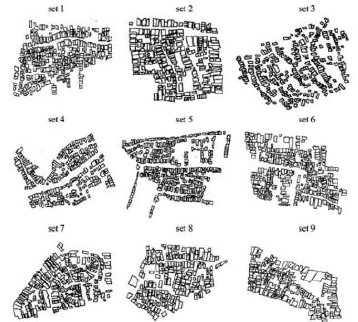
Figure 1. Map of Nine Informal Settlements, Recife Region, Brazil (Sobreira & Gomes, 2001)